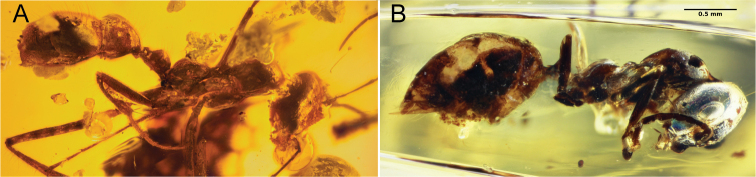
Body profiles of †Gerontoformica
pilosa and orientalis species groups A †Gerontoformica
pilosa Barden & Grimaldi, 2014, worker profile (ANTWEB1038931) B †Gerontoformica species, worker profile (ANTWEB1032649).